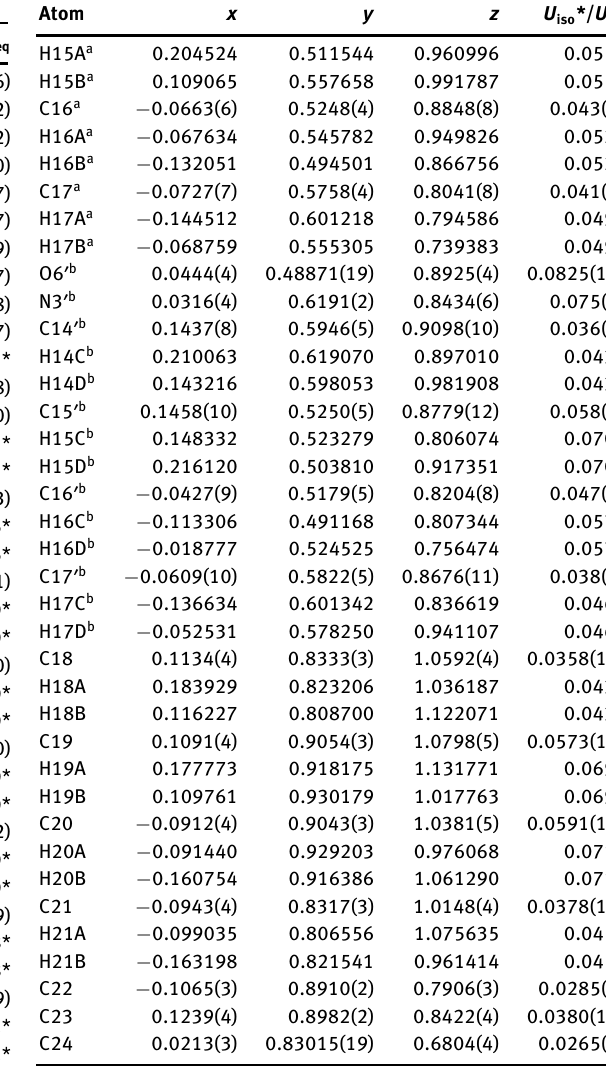
Table 2: Fractional atomic coordinates and isotropic or equivalent isotropic displacement parameters (Å 2